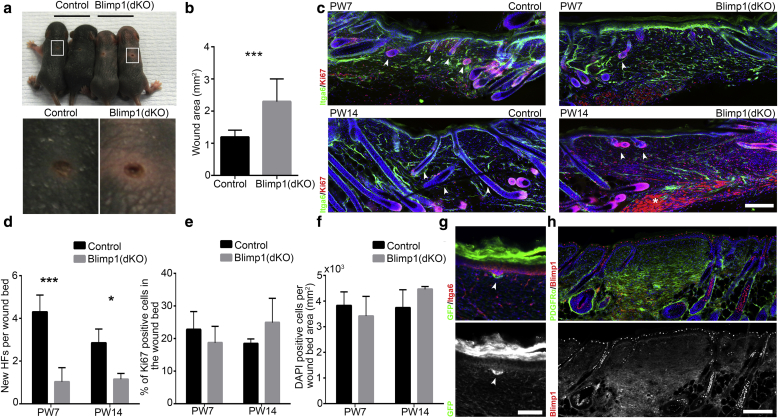
Effect of dermal Blimp1 deletion on skin regeneration in neonatal wounds. (a) Picture of P2 wounded mice at PW7 (upper panel). The lower panel shows a close-up of boxed wound areas in the upper panel. (b) PW7 wound area quantification. (c) Immunostaining of PW7 and PW14 wound beds for Itga6 and Ki67. Arrowheads indicate new HFs and the asterisk indicates unspecific Ki67 staining in the lower wound bed. (d–f) Quantification of (d) new HFs per wound bed, (e) Ki67+ dermal cells in the wound bed area, and (f) dermal cells in the wound bed area at PW7 and PW14. (g) PW7 neonatal wound immunostained for Itga6 and GFP in Blimp1GFP reporter mice. The arrowhead indicates high GFP expression around new forming HFs. (h) Immunostaining for PDGFRα and Blimp1 10 days after wounding P21 old mice. Data shown are means ± standard deviation. ∗P < 0.05, ∗∗∗P < 0.0005. Scale bars = 50 μm (g), 100 μm (h). Blimp1, B-lymphocyte-induced maturation protein 1; HF, hair follicle; PW, postwounding.